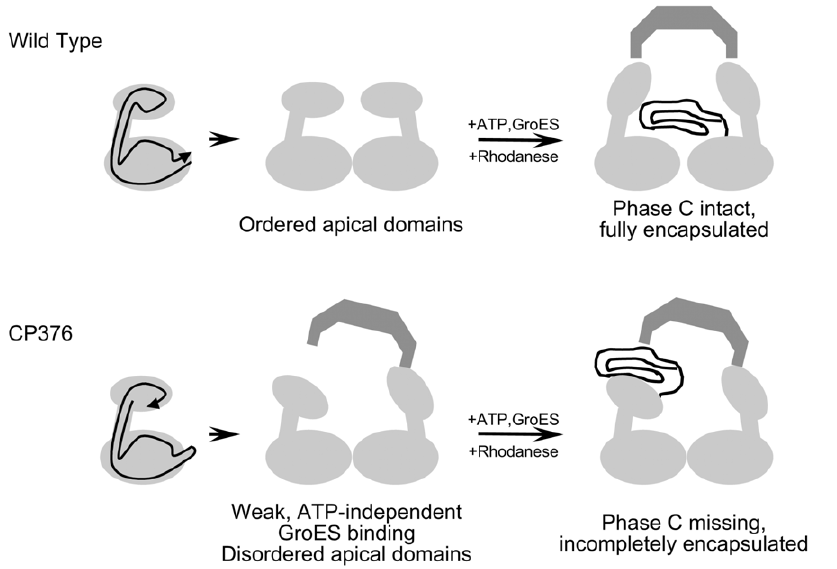
Figure 9. A summary of our findings regarding the CP376 GroEL mutant. For simplicity, only one ring of the GroEL 14-mer is shown. In wild type GroEL ( upper ), the apical domains are arranged about the heptameric ring in an orderly fashion, and through Phase C, act in a coordinated manner to encapsulate and sequester folding intermediates of rhodanese. In CP376 ( lower ) however, this orderly orientation is disrupted, and both static and dynamic characteristics of encapsulation are affected. The dynamic aspects of apical domain disorder were observed by the disappearance of the Phase C kinetic transition in stopped-flow experiments, and the static consequences were reflected in an incomplete encapsulation of refolding rhodanese molecules that resulted in Proteinase K sensitivity of the football complex, as well as an ability to bind the cochaperonin GroES in the absence of ATP. Electron micrographs, CD spectra, and stopped-flow assays suggested that these results were caused by an increased flexibility of the apical domain as a functional unit, rather than by an unfolding of this domain caused by circular permutation (for example, the tryptophan fluorescence of CP376-RW continued to reflect various conformational changes of the GroEL subunit in a manner analogous to the wild type subunit).